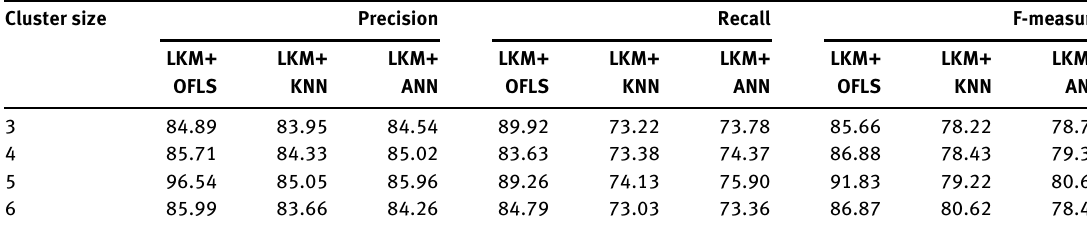
Table 8: Comparative Analysis Based on Different Classifier by Varying Cluster Size. Cluster